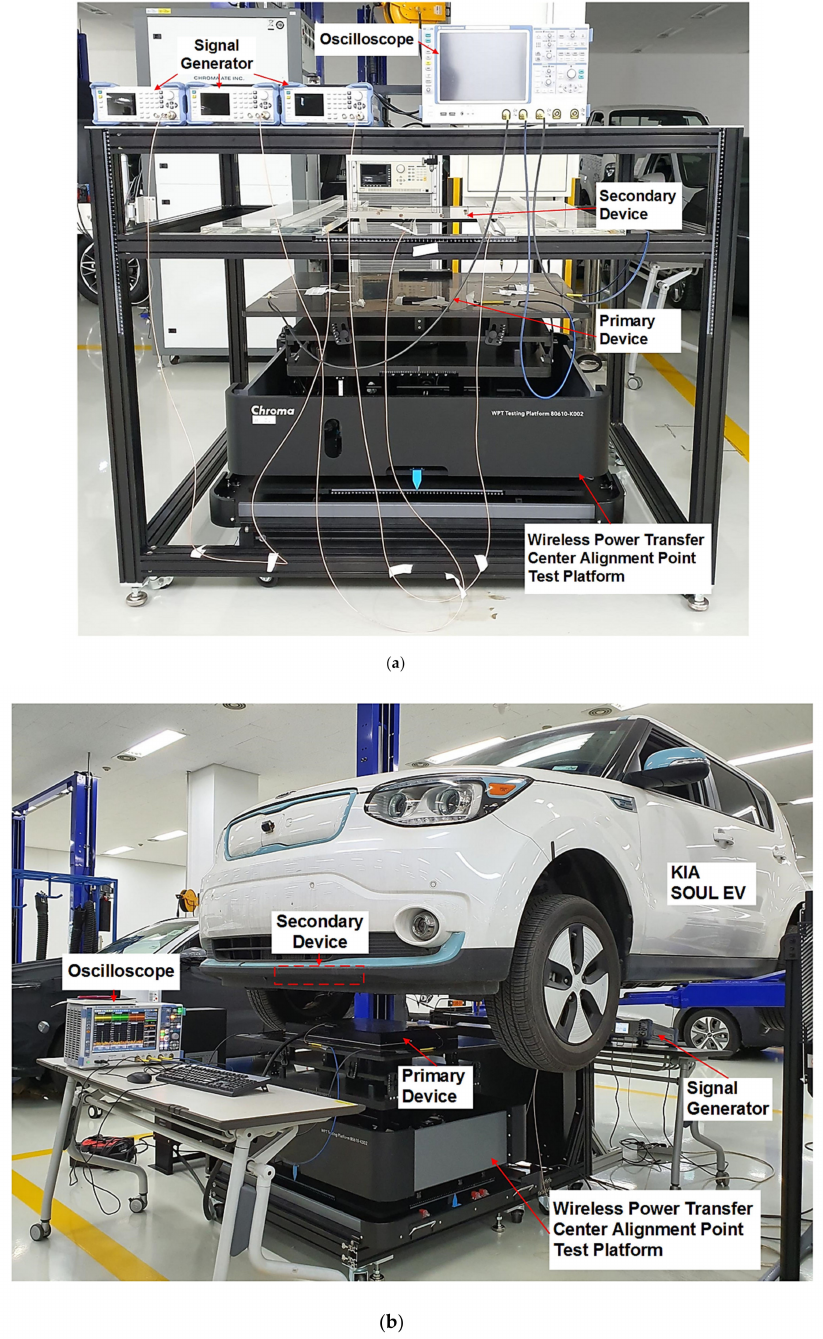
Figure 18. Experimental test conditions. ( a ) Component-level test; ( b ) vehicle-level